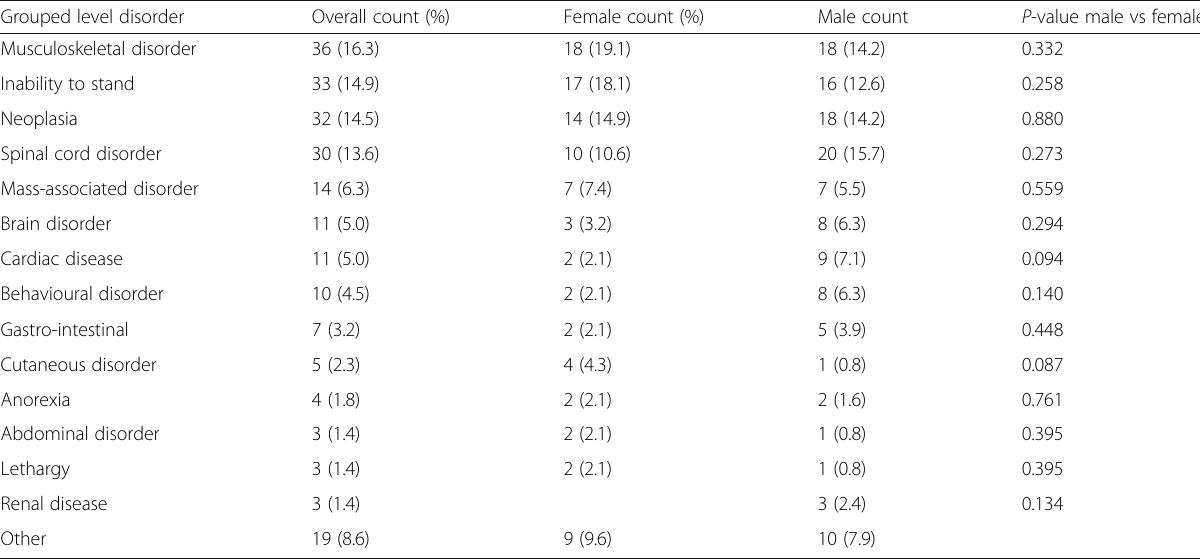
Table 2 Mortality in German Shepherd Dogs with a recorded cause of death under primary-care veterinary at UK practices participating in the VetCompass TM Programme from January 1st, 2013 to December 31st, 2013 ( n =